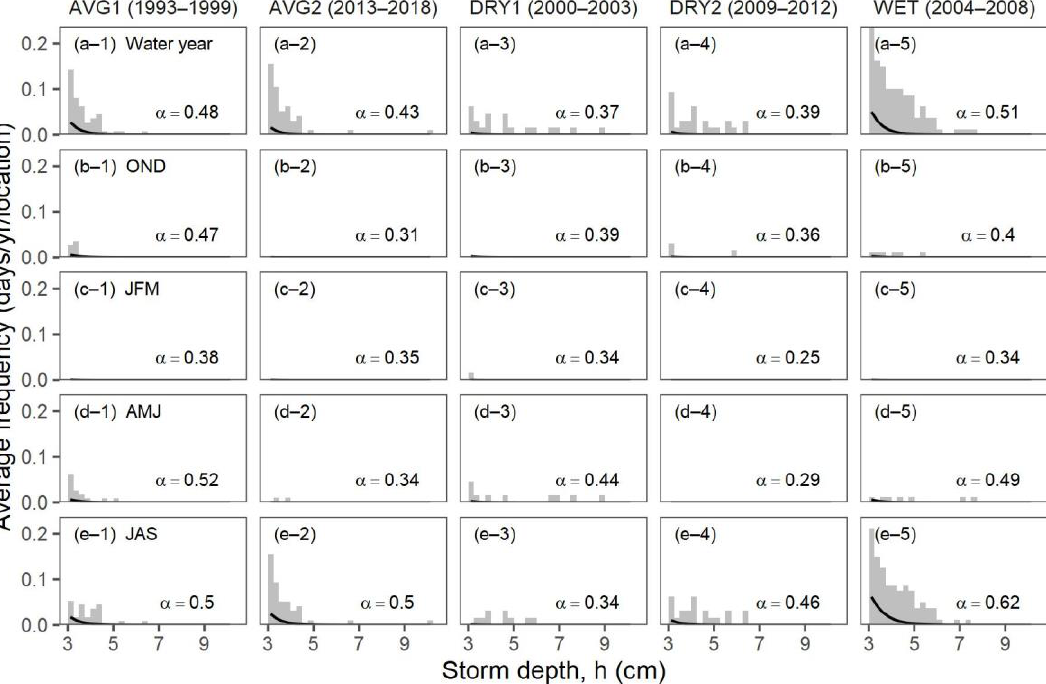
Figure 4. As in Figure 3 except for depths ≥ 3 cm .